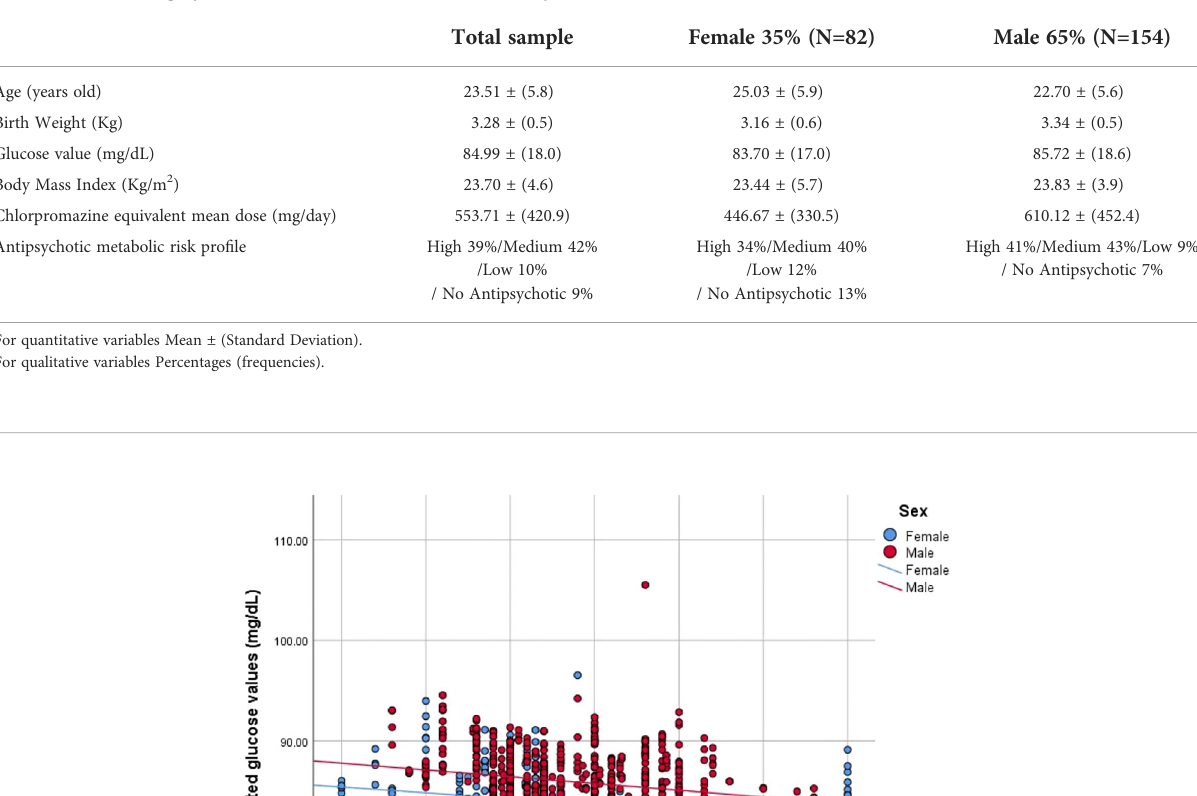
TABLE 1 Sociodemographic and clinical characteristics of the sample.